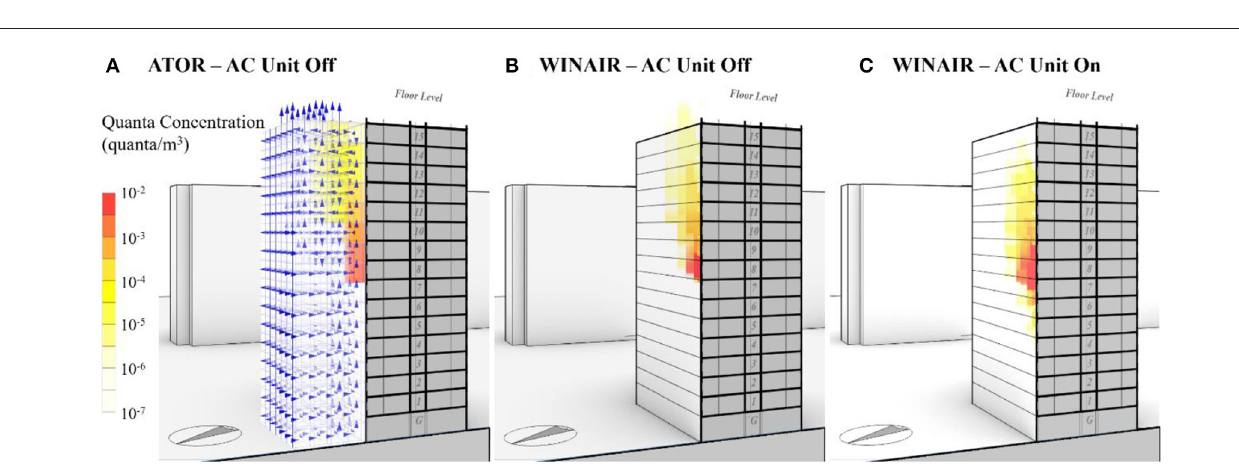
is in the same building with the primary patient (1 = yes). It